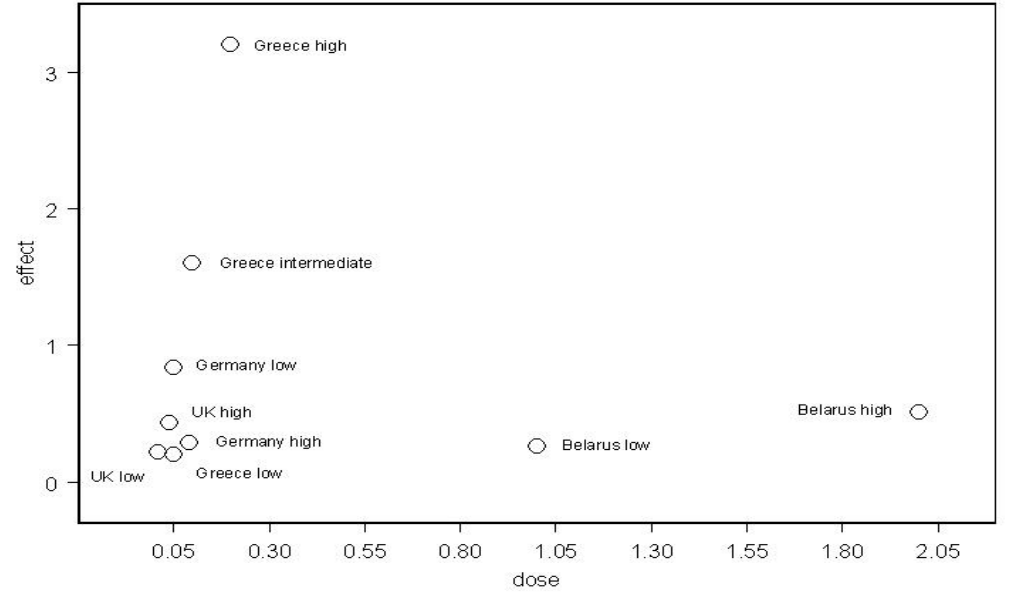
Figure 1. Dose response for infant leukemia in the countries examined by this study and CERRIE. (Data from CCRG and CERRIE [15]. Effect is fractional excess risk, and dose is in